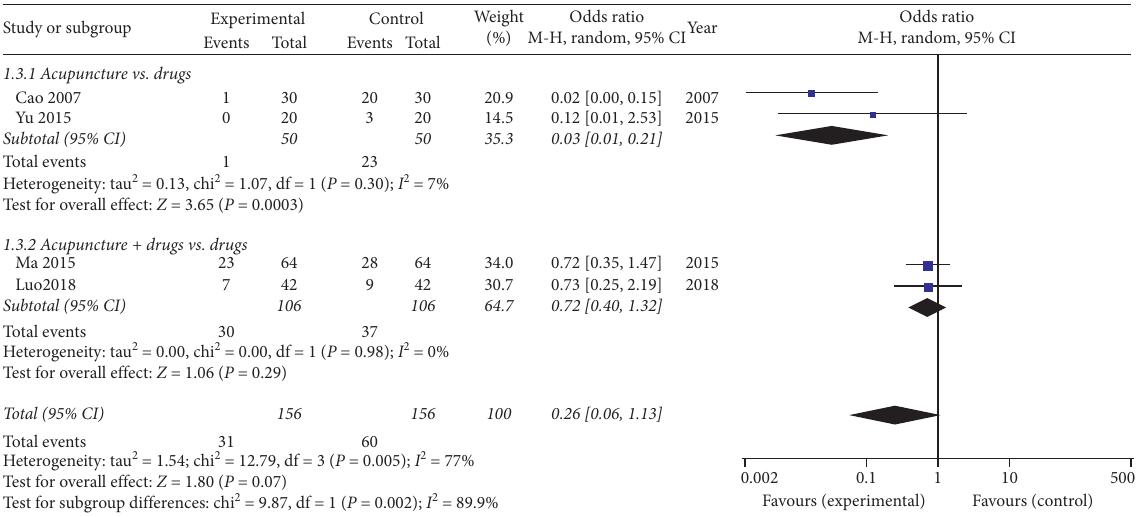
Figure 6: Meta-analysis for adverse events of acupuncture versus the control